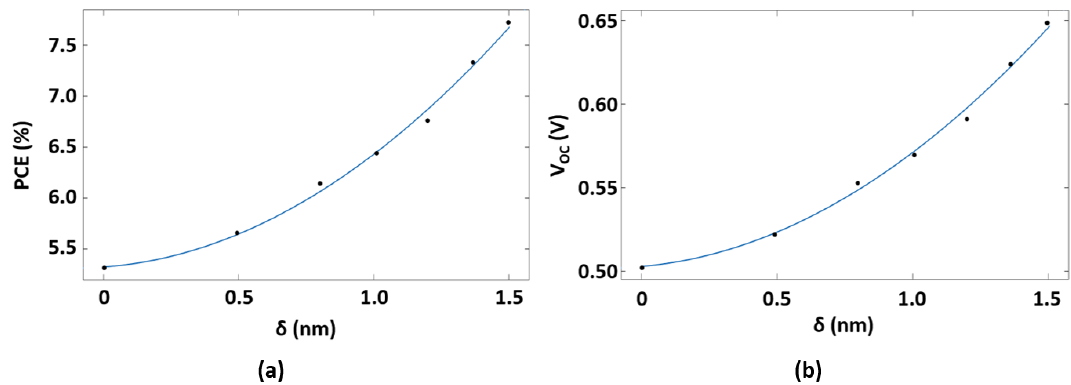
Figure 6. ( a ) PCE dependence on the thickness of the silicon oxide layer. ( b ) Open-circuit voltage vs. δ . Number of atomic layers forming the graphene sheet = 3, solar cell with GO ARC, H = 10 μ m, and N D = 10 15 cm − 3 .